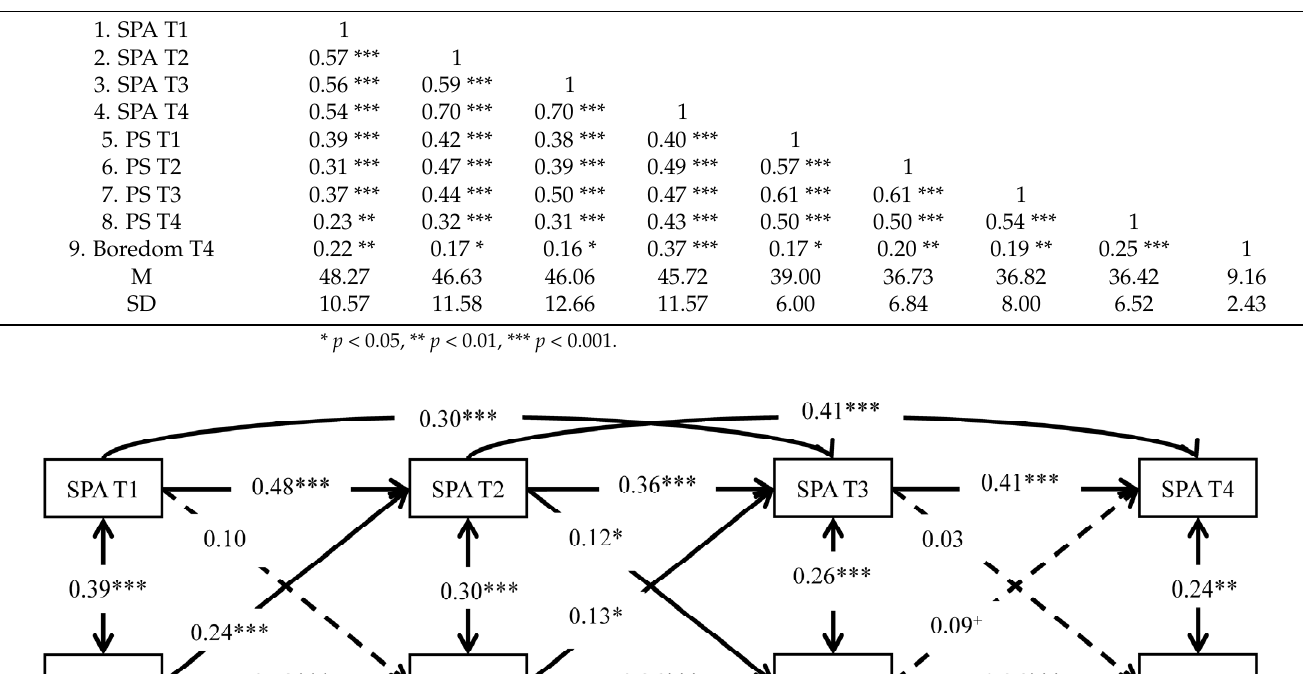
variables (N = 197).